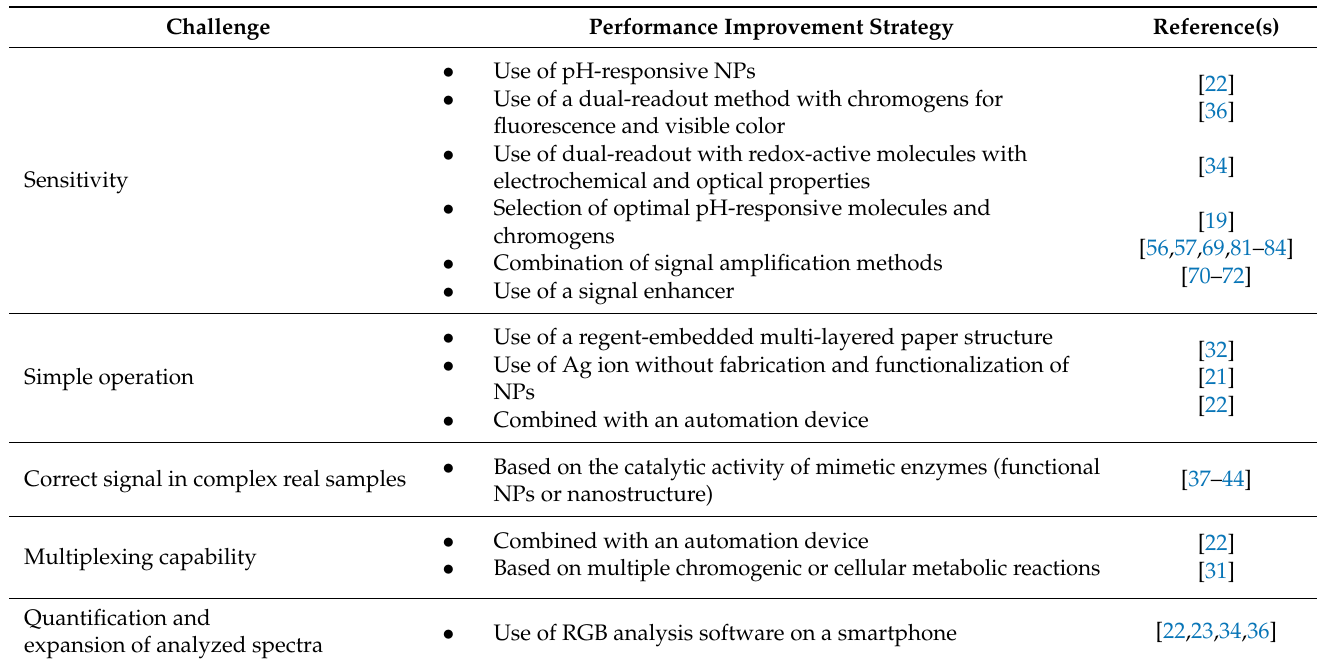
Table 2. Challenges and strategies to improve the performance of colorimetric systems for the detection of bacterial